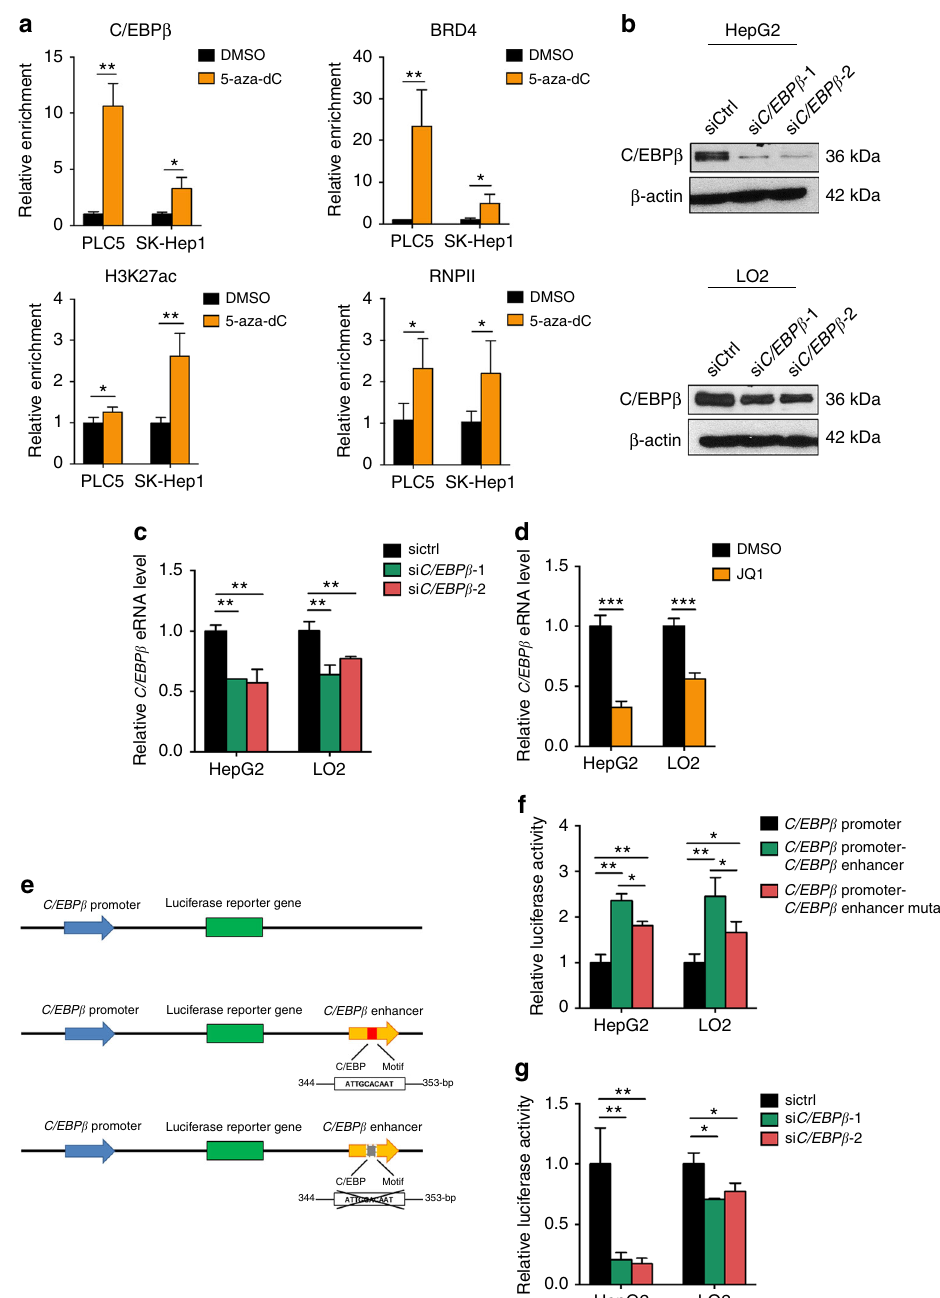
Fig. 3 C/EBP β auto-regulates its enhancer activity. a qChIP-PCR showed enrichment of C/EBP β , BRD4, H3K27ac, and RNPII at C/EBP β enhancer